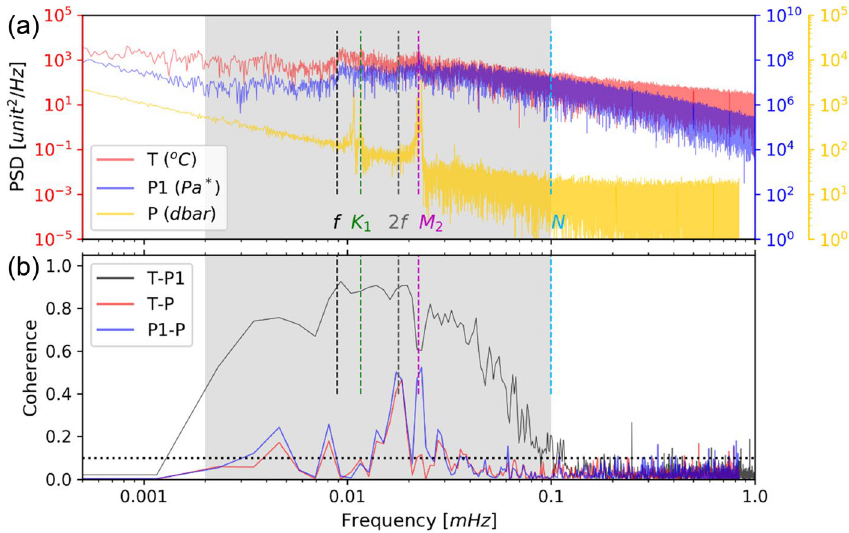
Figure 2. Spectral information. ( a ) Spectra of data from the T-sensor at 3131 m (T, red), from the differential pressure gauge (DPG) P1 at 3039 m (P1, blue, scale to the right), and from the pressure sensor at the current meter at 2936 m (P, yellow, scale to the far-right) for the period between September 1, 2017 and April 20, 2018. ( b ) Coherence between T and P1 (black), T and P (red), and P1 and P (blue). Dashed light blue, magenta, gray, green, and black lines mark the local buoyancy frequency (N), lunar semidiurnal frequency (M 2 ), local double inertial frequency (2f), lunar diurnal frequency (K 1 ), and local inertial frequency (f), respectively. Gray shades show the filtered bandwidth we used in this